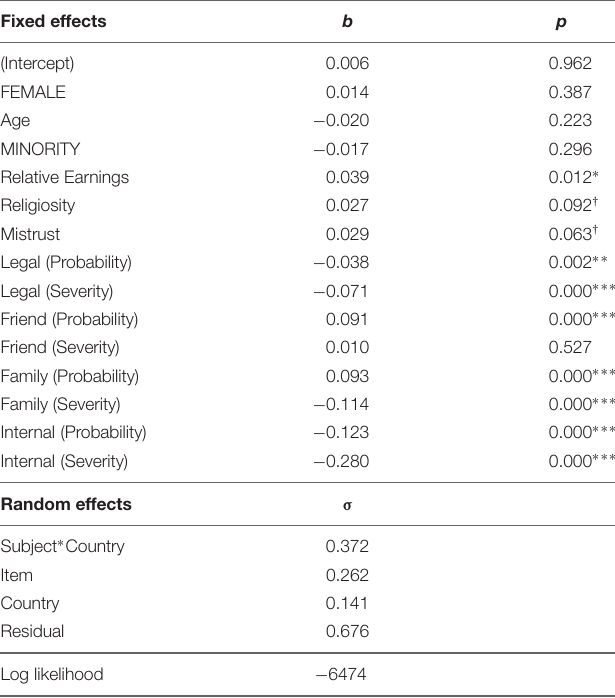
TABLE 3 | Results from a linear mixed effects models (ML estimation) for likelihood of engaging in crime, with probability and severity ratings for legal, friend, family, and internal sanctions entered as predictors, in addition to demographic